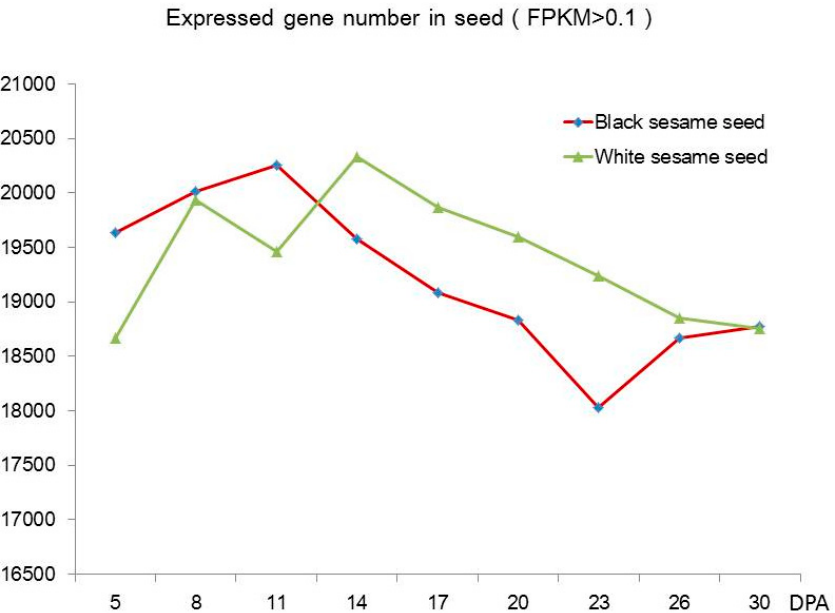
Figure 3. Expressed genes numbers at di ff erent DPA in black and white sesame. FPKM: Fragments Per Kilobase of transcript per Million reads.